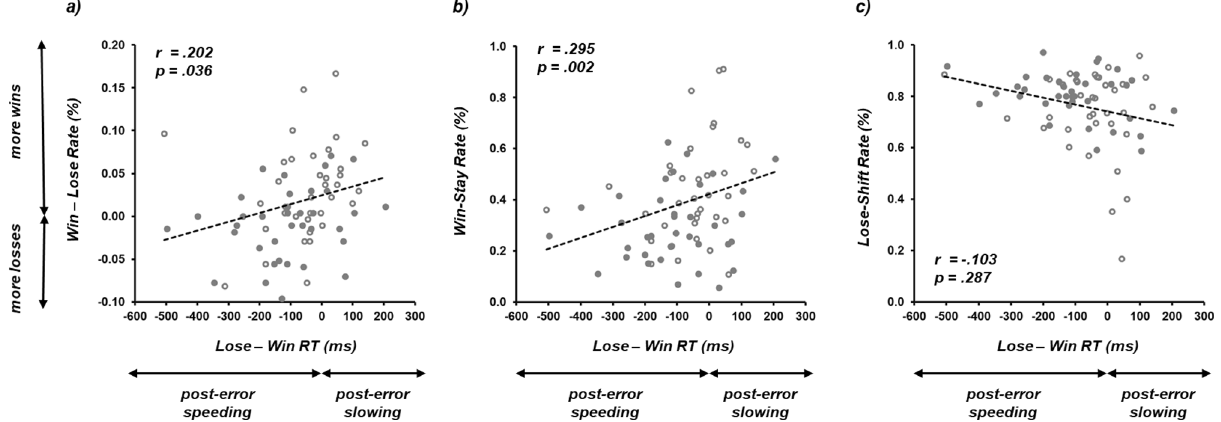
Figure 2. ( a ) Scatterplot comparing average lose minus win reaction time (RT) indexing the degree of post- error speeding (lose < win) or post-error slowing (lose > win) against the rate of wins minus losses indexing participants who were successful (more wins) or unsuccessful (more losses). The significant, positive correlation ( r = 0.202, p = 0.036) shows that slowing down decision-making following losses relative to wins increases the likelihood of future successful performance. ( b ) Scatterplot depicting the significant, positive correlation ( r = 0.295, p = 0.002) between the degree of post-error slowing and individual expressions of win-stay behaviour. ( c ) Scatterplot depicting the lack of a significant correlation ( r = − 0.103, p = 0.287) between the degree of post-error slowing and individual expressions of lose-shift behaviour. Across ( a – c ), filled-in circles represent participants from Experiment 2 ( n = 36) and unfilled circles represent individual participants from Experiment 3 ( n =